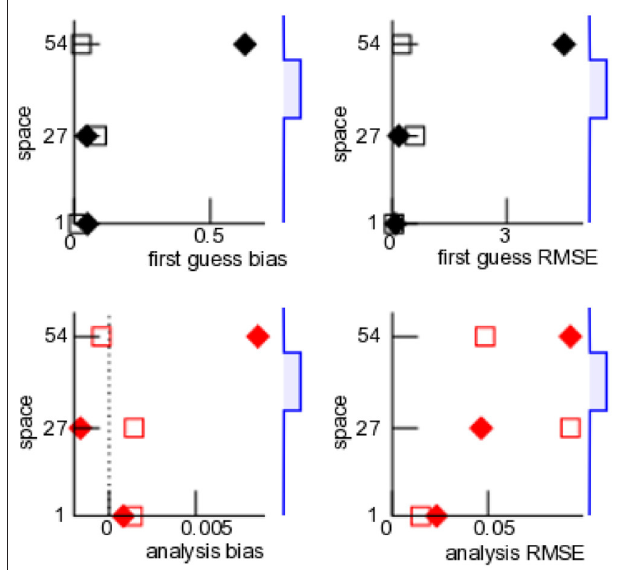
FIGURE 1 | Example for effect of nonlocal observations on departure statistics. Verification of model equivalents in observation space by local observations at three spatial positions ( x 1,27, and 54) for assimilation of = local observations only (open squares) and assimilation of local observations and nonlocal observation (solid diamonds). The blue-colored line sketch on the right hand side reflects the sensitivity function of the nonlocal observation with center at x 40 and the width r H 10; the localization radius is r l 10. = = = Further details on the model, observations and assimilation parameters are given in section